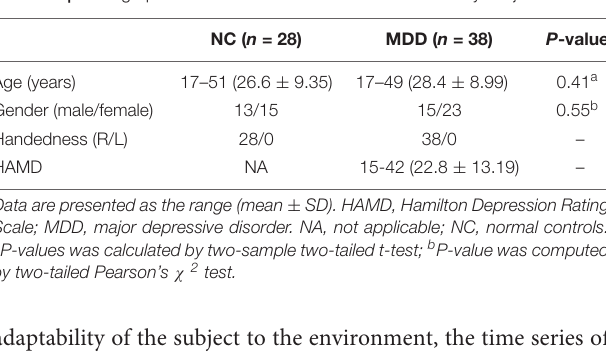
TABLE 1 | Demographics and clinical characteristics of the study